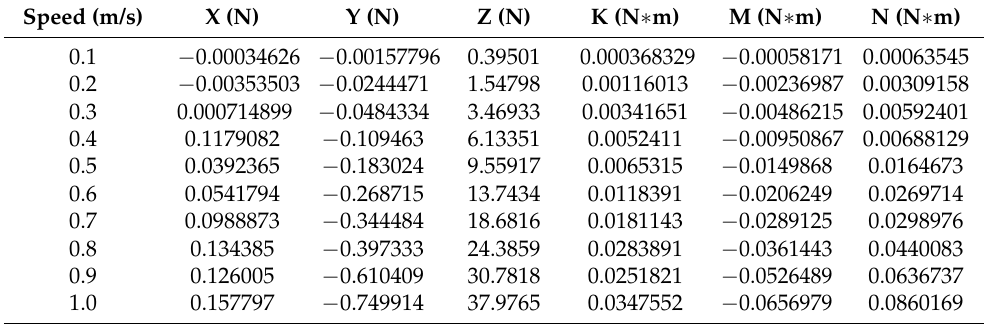
Table 3. Viscous hydrodynamic moment test